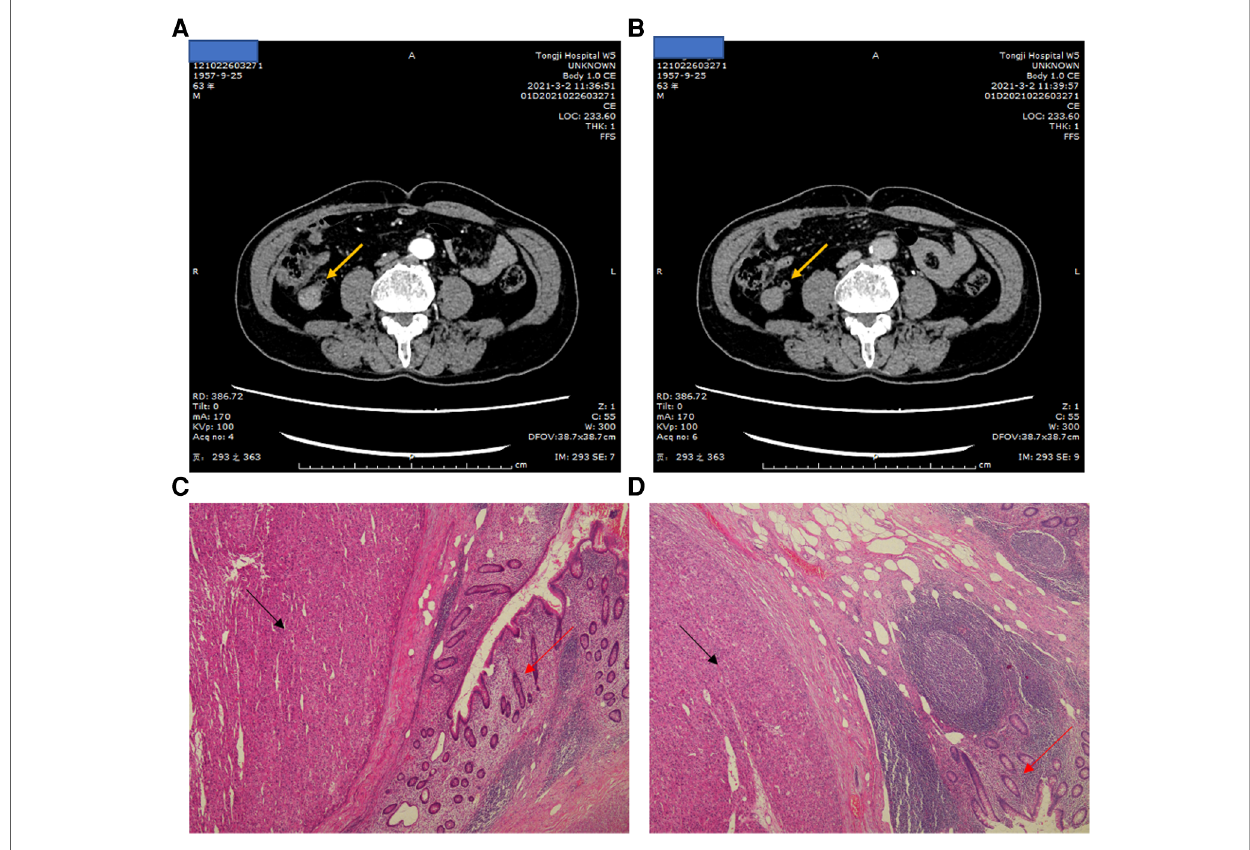
FIGURE 2 ( A ) Arterial phase of the Liver-enhanced computed tomography (CT) showing the tumor lesion in the appendix, the arrow point at the appendix. ( B ) portal venous phase of the the Liver-enhanced computed tomography (CT) showing the tumor lesion in the appendix, the arrow point at the appendix. ( C , D ) The HE stain of pathological diagnosis. The black arrow point at tumor lesion. The red arrow point at the